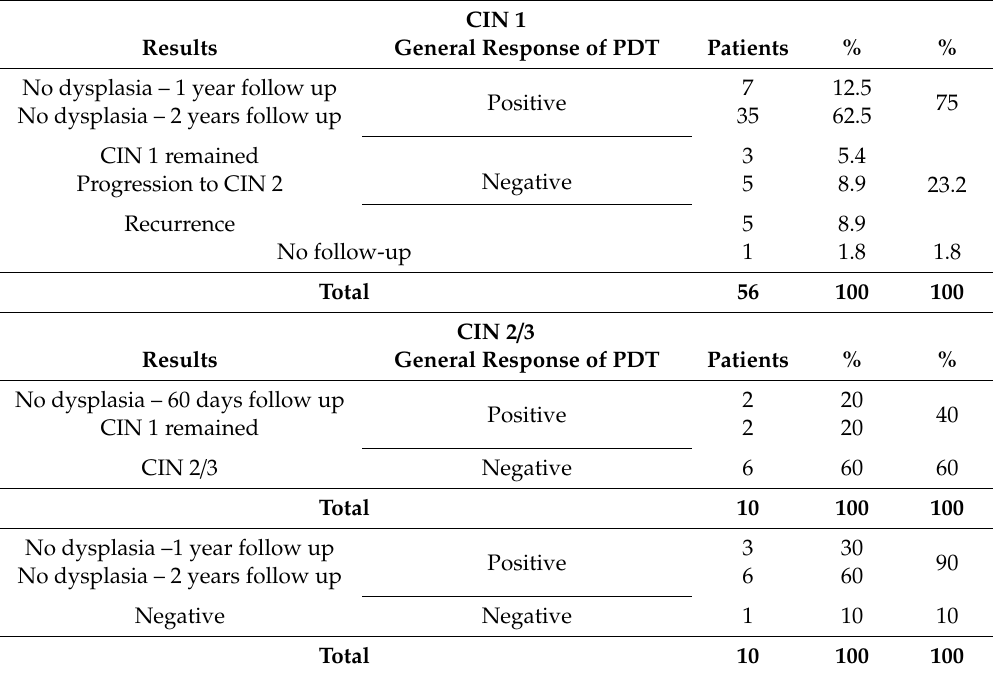
Table 1. Summary of results from patients treated with photodynamic therapy (PDT) for cervical intraepithelial neoplasia (CIN) 1 and 2 / 3.